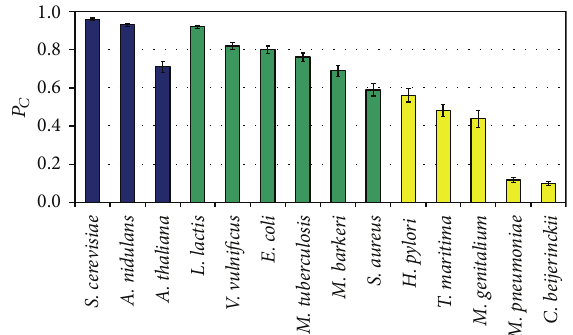
Figure 2: Average 𝑃 𝐶 for the fourteen metabolic network models. The histograms for group 1 (eukaryotes), group 2 (“free-living” prokaryotes), and group 3 (highly-adapted prokaryotes) are shown in dark blue, green, and yellow, respectively. The error bars in this plot are the 95% confidence intervals based on one-sample t